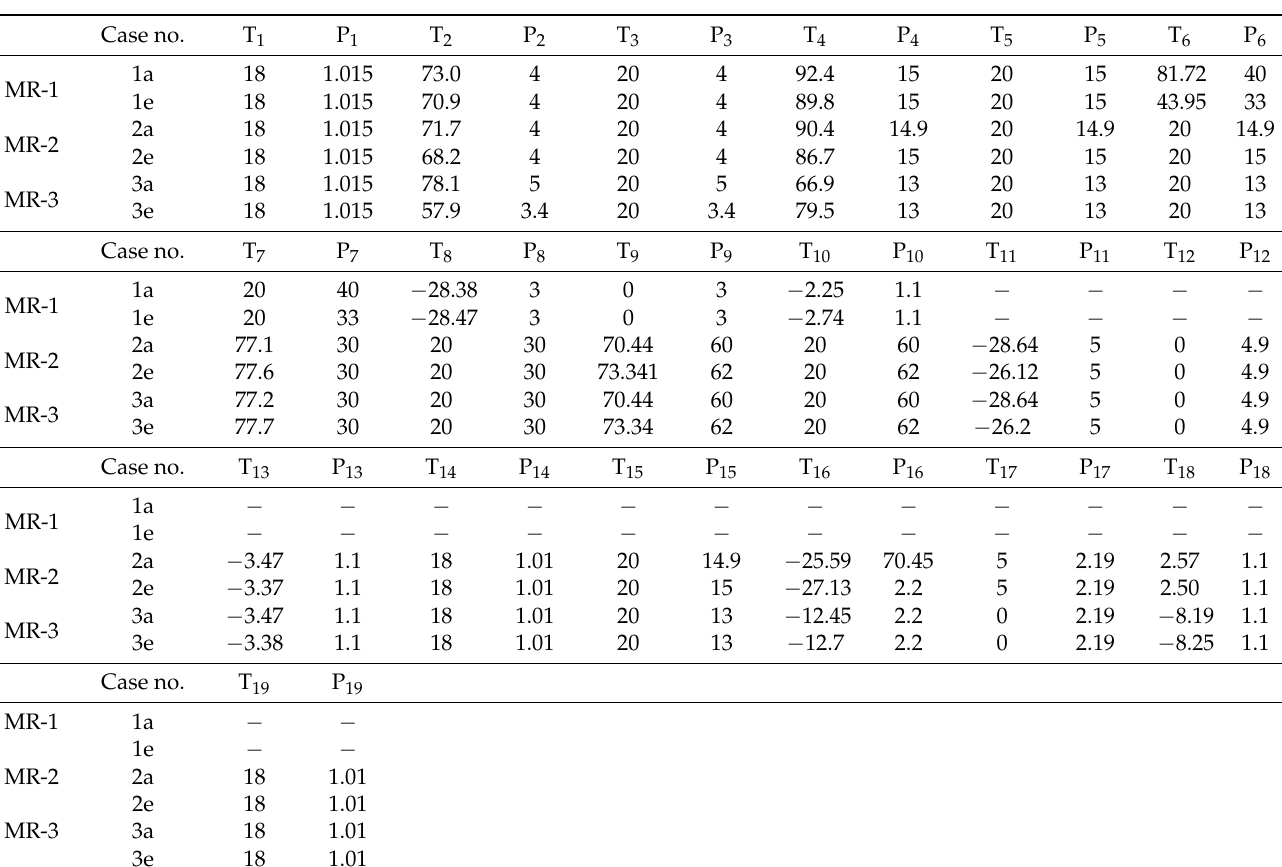
Table A1. Temperature ( ◦ C ) and Pressure ( bar ) data of proposed pre-cooling